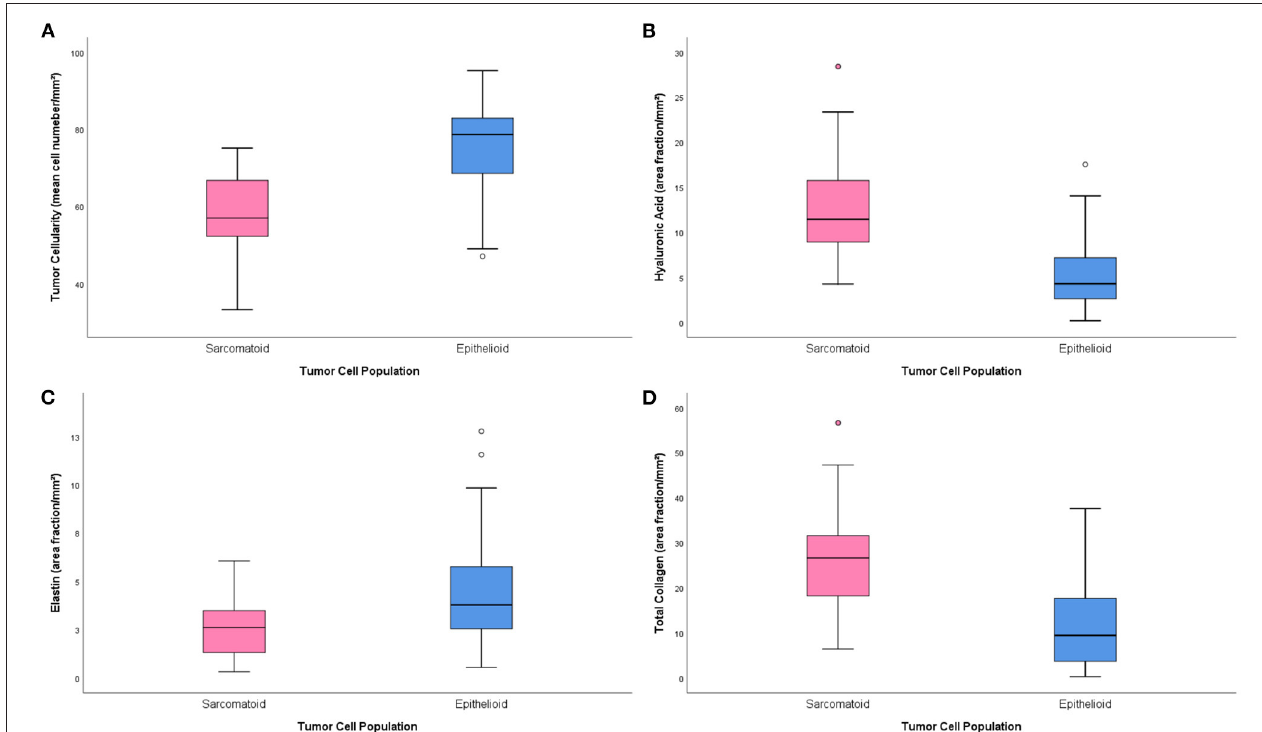
FIGURE 2 | Boxplots of the distribution of matrix elements [cellularity (A) , hyaluronic acid (B) , fibrin (C) and total collagen (D) ] between the epithelioid and sarcomatoid groups.